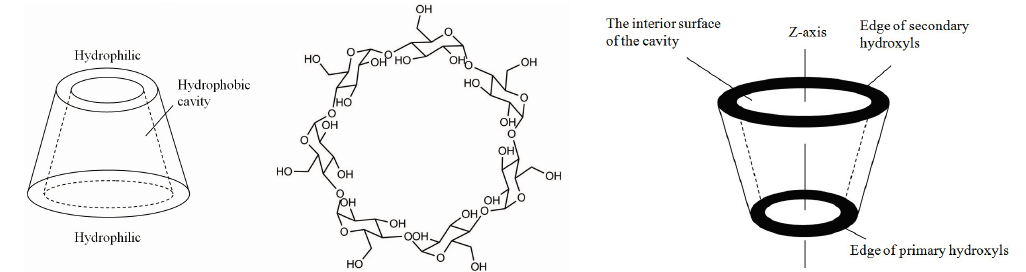
Figure 1. Chemical structure of β